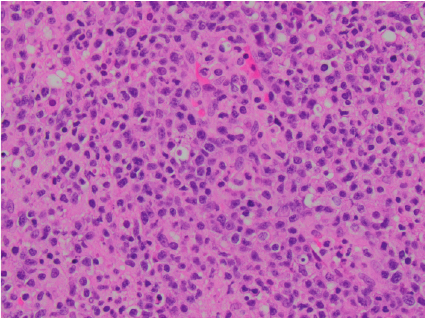
Figure 3: There were dense atypical lymphoid cells with irregular nucleoli (H&E stain, 400X).